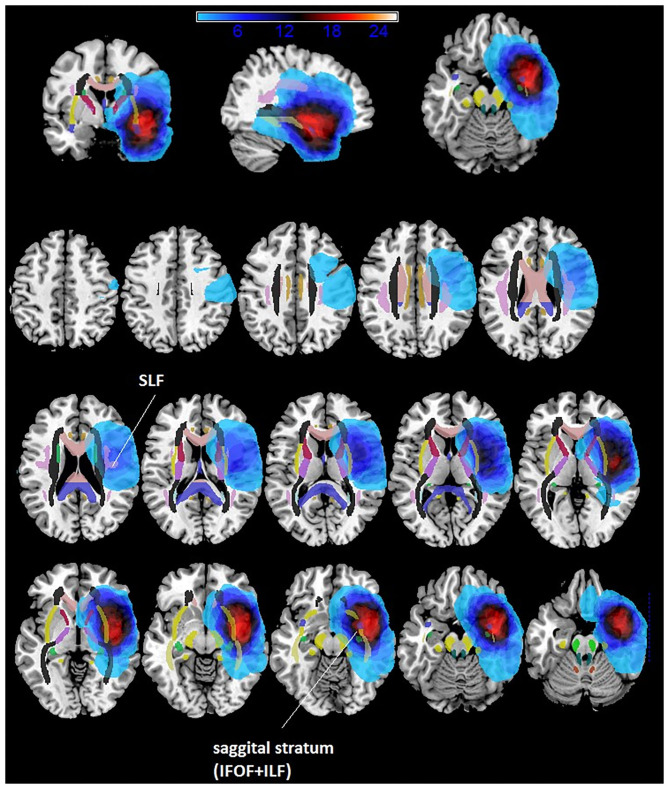
Overlaps of lesions masks of patients with temporo-insular LGGs.